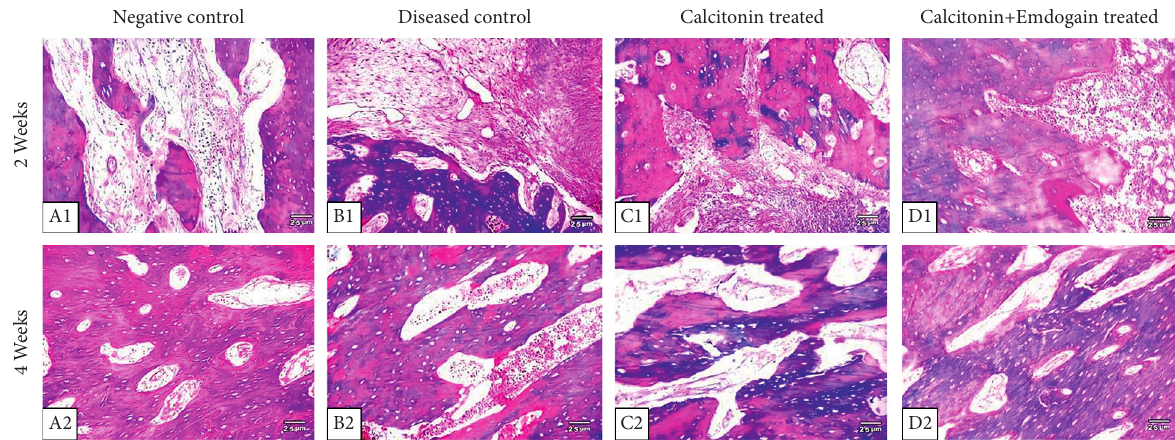
Figure 2: Histopathological sections of the 4 study groups at 2nd and 4th weeks; A1 and A2 represent the negative control group with newly formed collagen fibers radiating from the cavity periphery. B1 and B2 represent the positive control group which shows less Masson’s trichrome reaction. More positively stained osteoid tissues in the calcitonin- and the calcitonin+ emdogain-treated groups (C1 and D1 and C2 and D2, respectively) (trichrome stain, ×